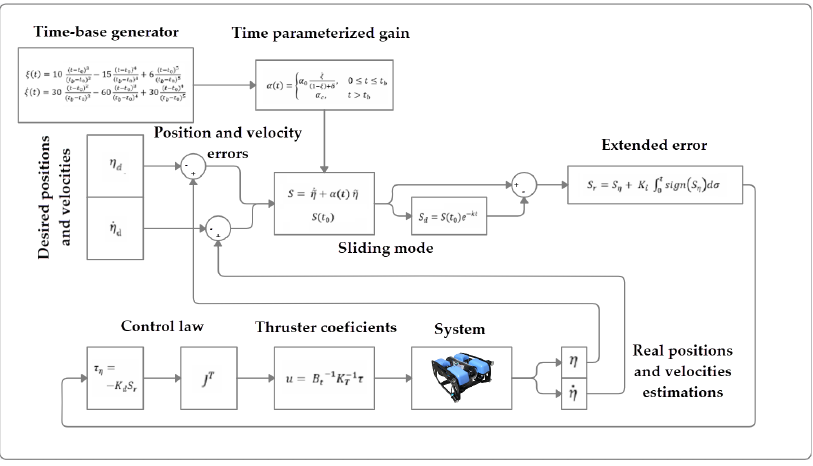
Figure 2. Model-free high-order SMC with finite time convergence block diagram.